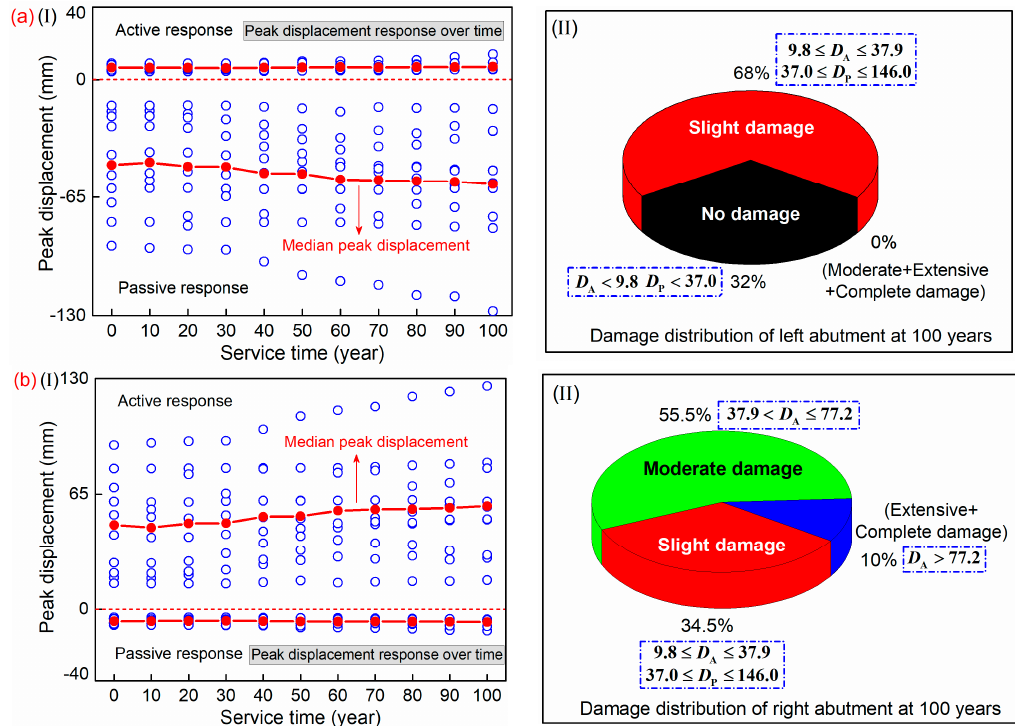
Figure 19. Peak displacement response over time and damage distribution of abutment: ( a ) left abutment; ( b ) right abutment.